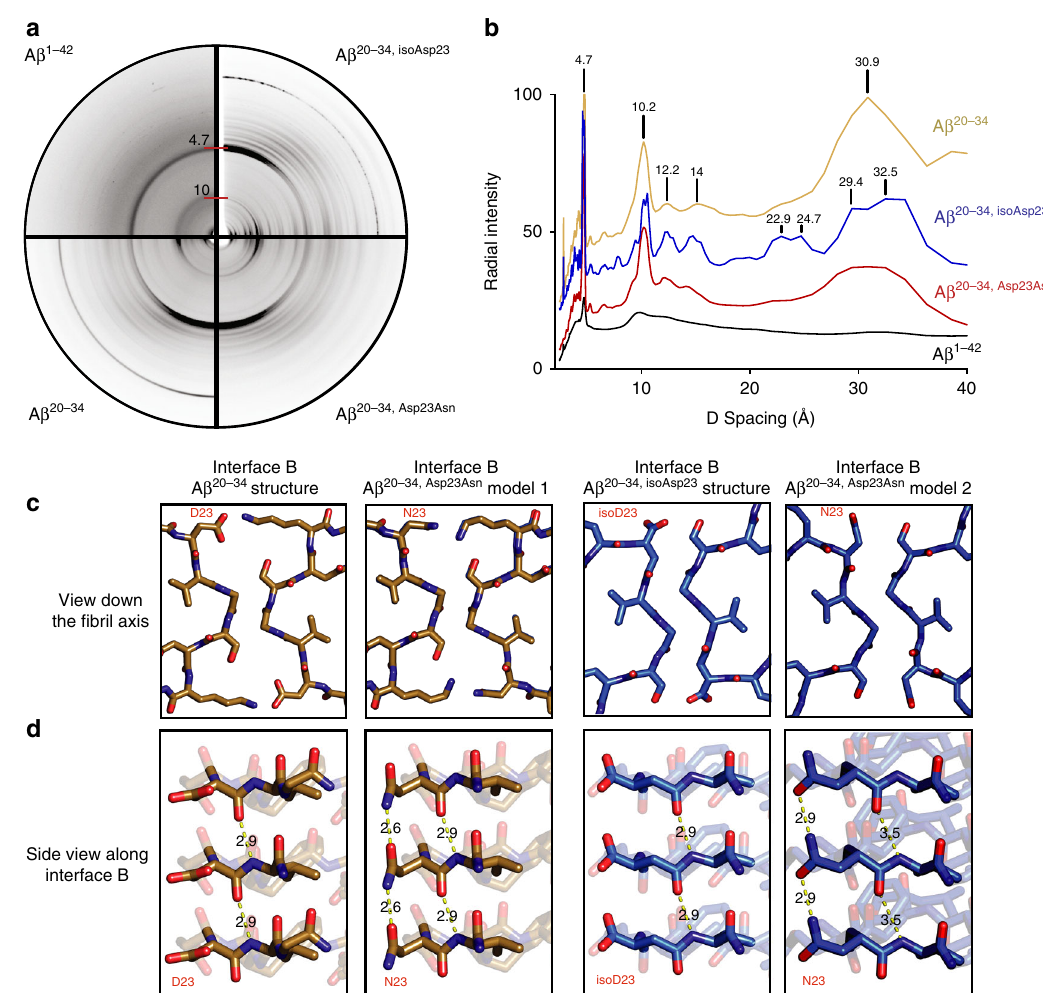
Fig. 4 A putative model of the heritable Iowa mutation in interface B. a Fiber diffraction patterns of A β 1 – 42, A β 20 – 34 , A β 20 – 34, isoAsp23 , and A β 20 – 34, Asp23Asn . All fi bers including A β 1 – 42 were prepared in 50 mM Tris, pH 7.6, 150 mM NaCl, and 1% dimethyl sulfoxide (DMSO), except A β 20 – 34, Asp23Asn , in which the DMSO concentration was raised to 5%. b Intensities of re fl ections from fi ber diffraction of the segments were plotted against D spacing. Radial intensity values are vertically staggered for visibility of peaks. c From left to right, interface B down the fi bril axis of A β 20 – 34 structure, a model A β 20 – 34, Asp23Asn on the backbone of the A β 20 – 34 structure, A β 20 – 34, isoAsp23 structure, and a model A β 20 – 34, Asp23Asn on the backbone of the A β 20 – 34, isoAsp23 structure. d A view perpendicular to the fi bril axis of residues 23 – 24 of each structure. Yellow dashed lines represent measured distances in Å between the amide carboxyl of residue 23 and the amide nitrogen of Val24 on the adjacent strand. Source data are provided as a Source Data fi